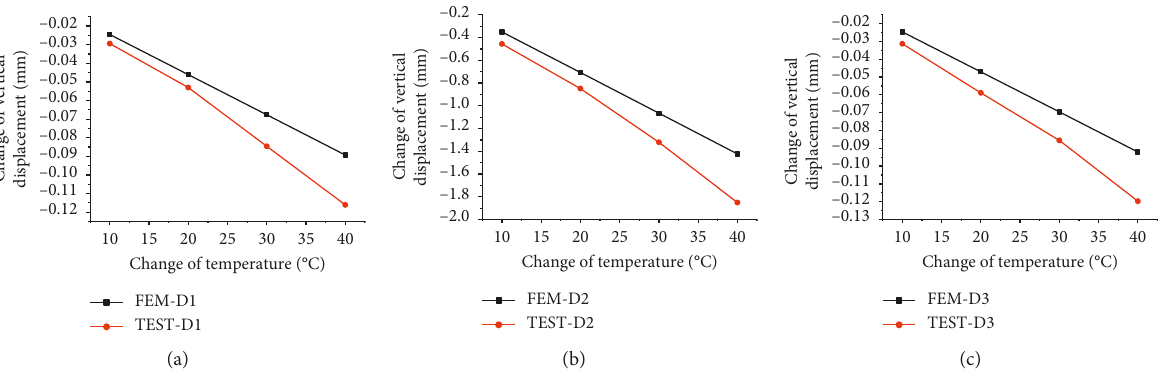
Figure 17: Comparison of the change in nodal displacement in the experiments and finite element numerical simulation under the full-span load. Displacement change of (a) D1, (b) D2, and (c) D3 under the full-span load.